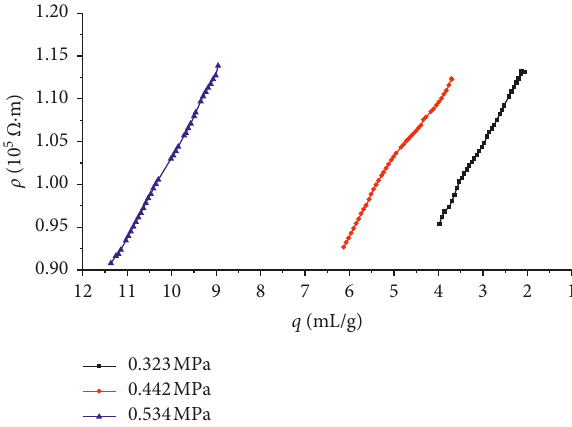
Figure 4: Resistivity vs. gas content during continuous